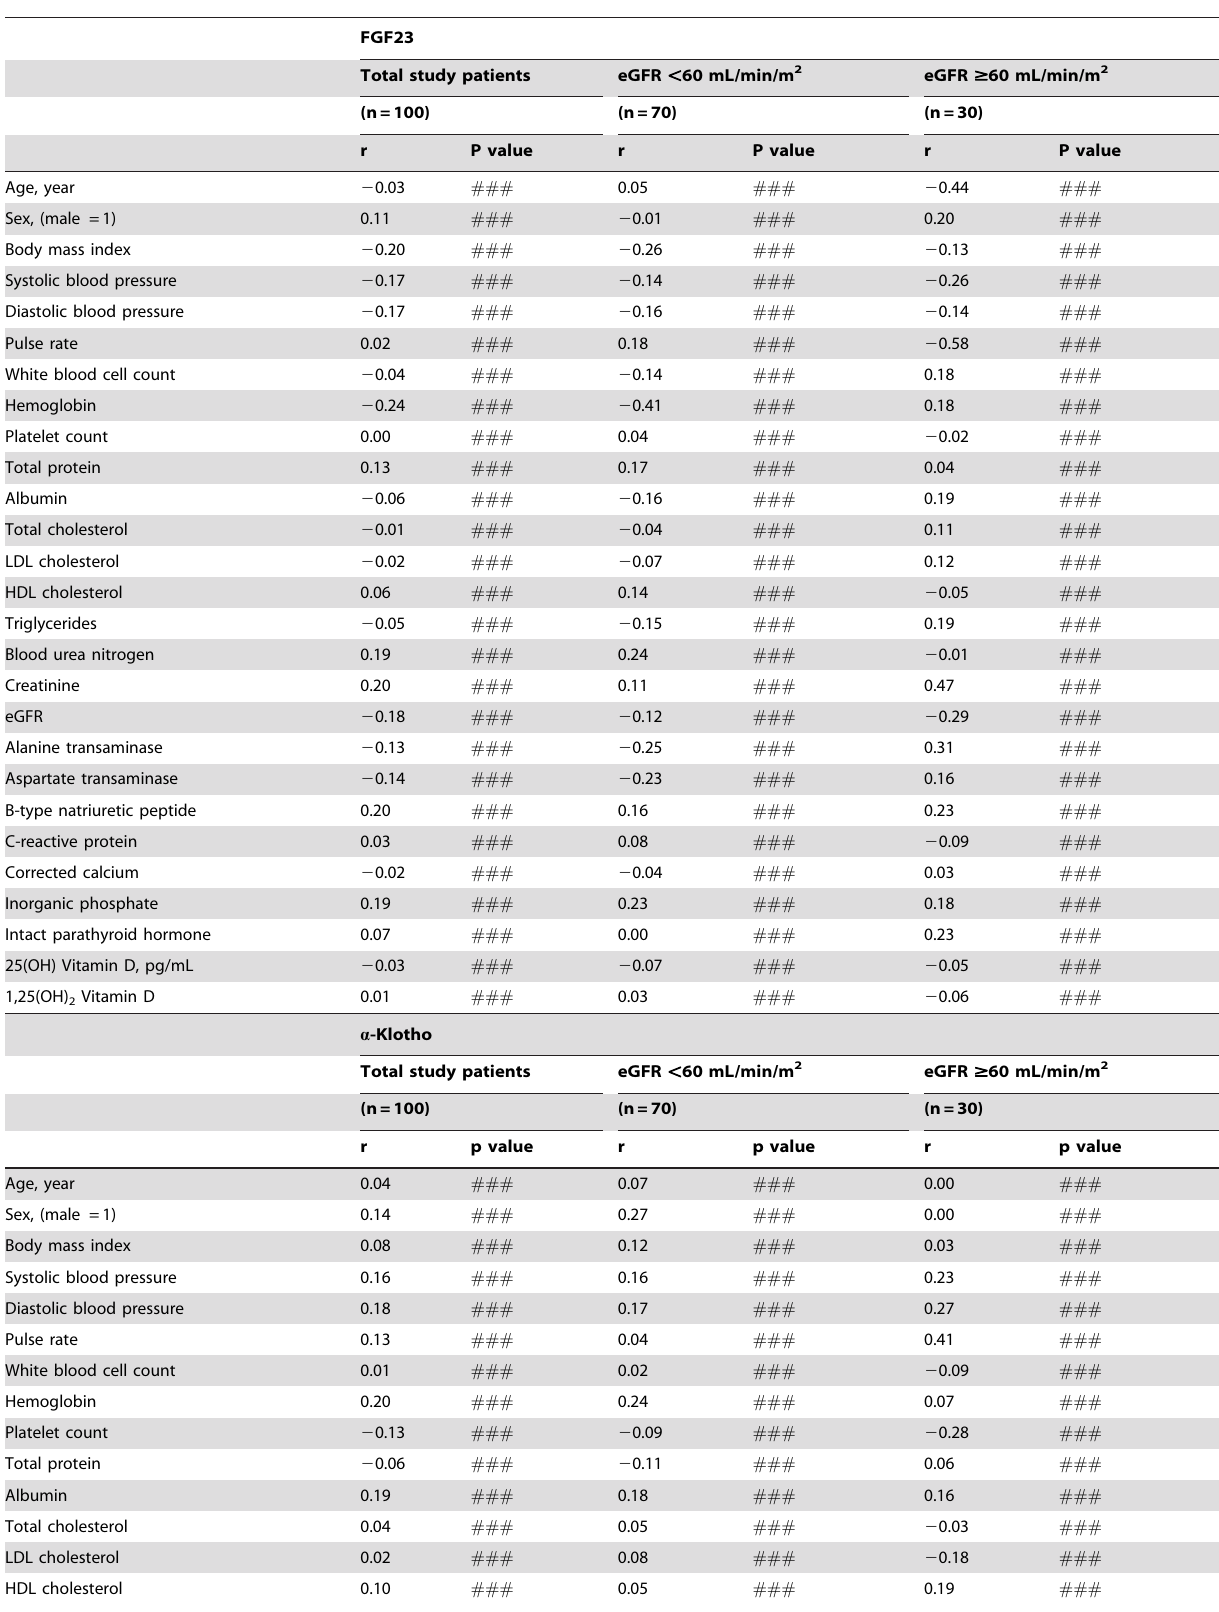
Table 4. Spearman’s correlation coefficients between a -Klotho and various